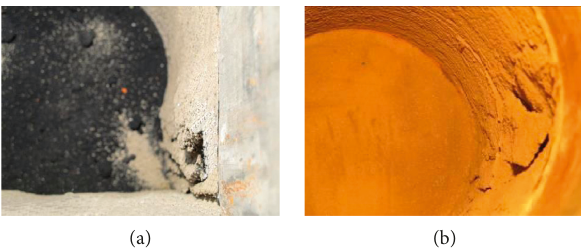
Figure 13: Destruction of the interior wall of tunnels with different cross sections under the maximum load in the physical model test. (a) Horseshoe tunnel T3: failure at the foot of the wall during pressure stabilization. (b) Circular tunnel T4: failure at the midheight of the side wall during pressure stabilization.